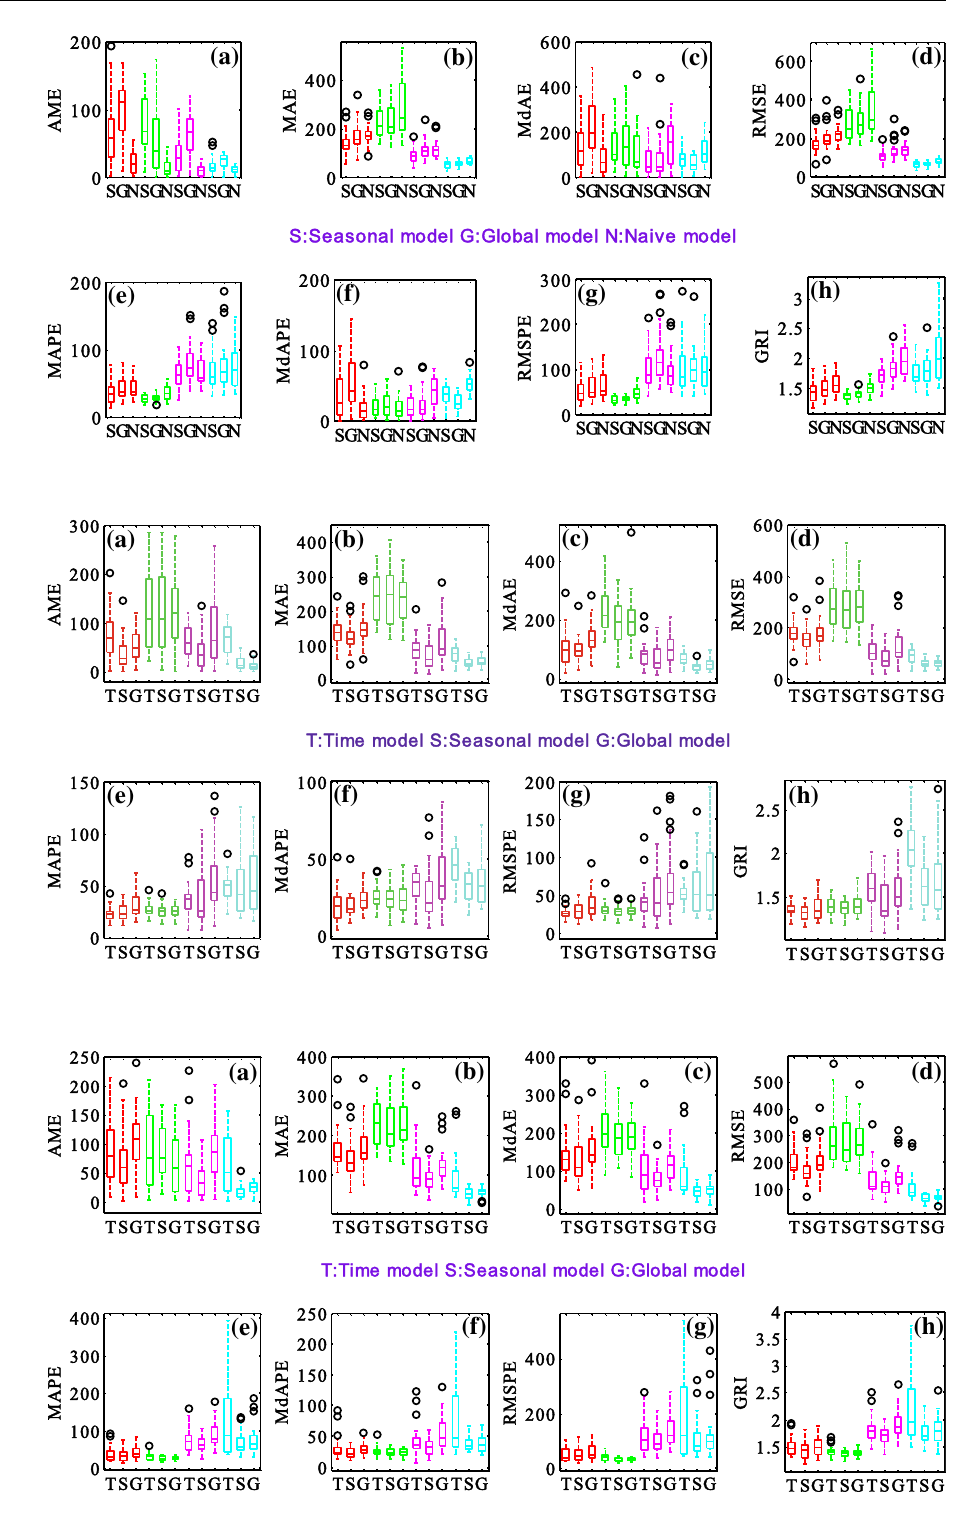
obtained from Fig. 14. However, when compared to Figs. 13, and 14 indicates that the longer the forecasting time, the smaller the advantage of the time model over the seasonal and global models in precipitation forecasting